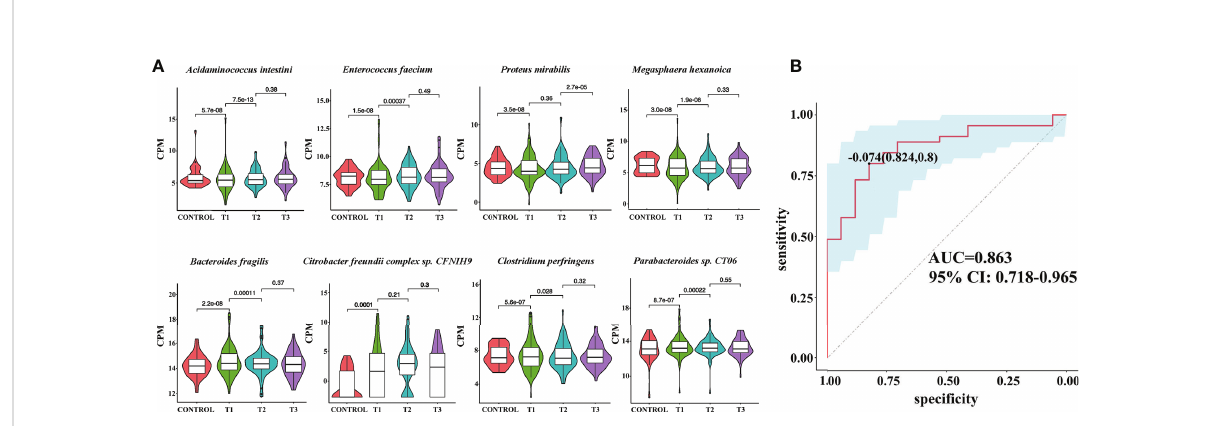
FIGURE 3 Metagenomic sequencing-based exploration of RAU-associated fecal microbiomes with those of healthy individuals and the prediction model based on fecal microbial species of RAU and healthy controls. (A) Violin plot analysis comparing the levels of fecal microbial species in control, T1, T2 and T3 groups ( P <0.05). The vertical position of each histogram represents the relative expression level of fecal microbial species. (B) Receiver operating characteristic curves for fecal microbial species comprising samples from RAU and healthy controls. “ 0.824 ” is the sensitivity of the optimal threshold point, and “ 0.8 ” is the speci fi city. “ -0.074 ” is the socre of adaboost modle at the optimal threshold point. The blue area 95% con fi dence represents the con fi dence interval.